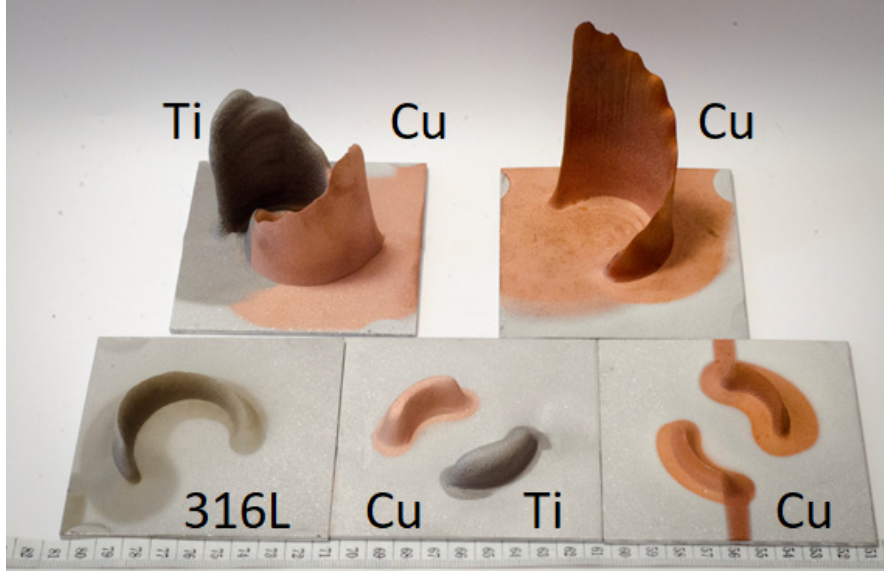
Figure 13. CSAM curved parts made by the Metal Knitting